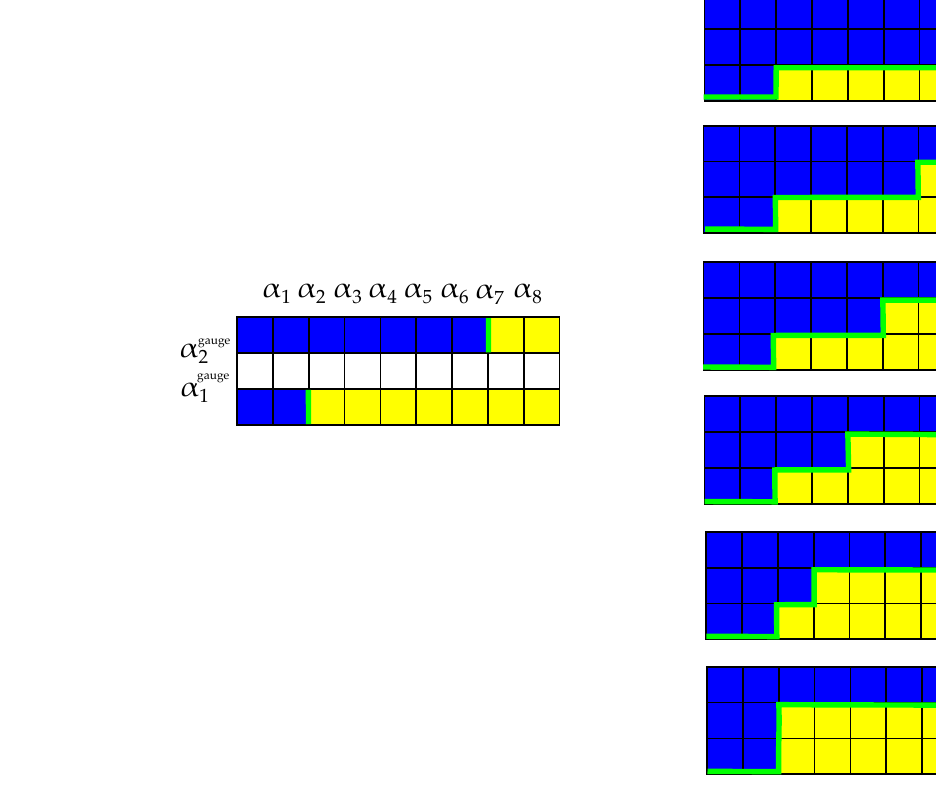
Figure 4. An example of a (cid:13)avor-equivalence class for SU(3)+9 F . The equivalence class is shown on the left-hand side | there we indicate in green the key characteristics of the associated box graph: the splitting of both roots of the gauge group (cid:11) gauge , i = 1 ; 2 combined will contain all the i roots (cid:11) 3 ; (cid:11) 4 ; (cid:11) 5 ; (cid:11) 6 . On the right-hand side, we show the complete set of box graphs that comprise the (cid:13)avor-equivalence class. E.g., the top diagram corresponds to the case where the splitting